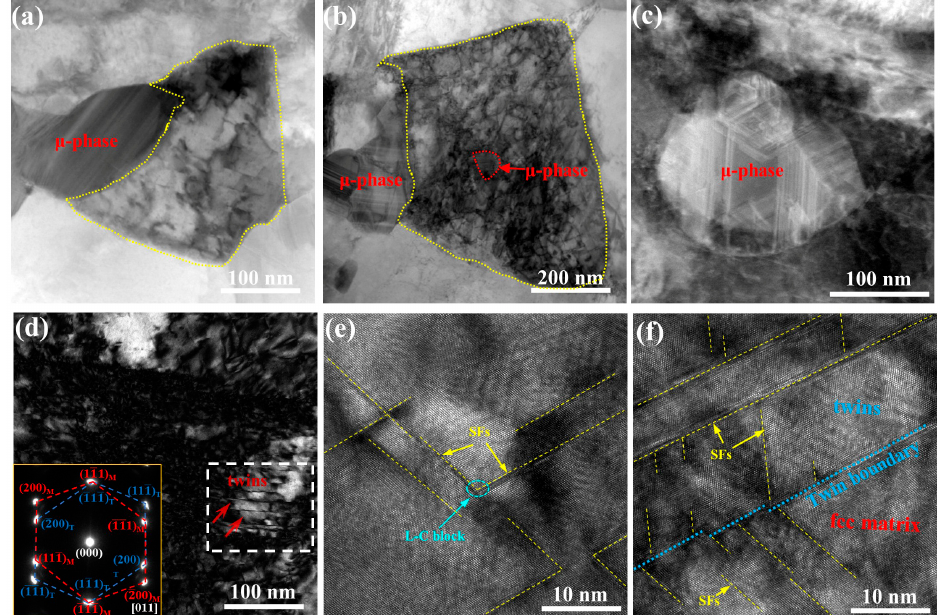
Figure 6. The room temperature deformation microstructure of the 1000 ◦ C − annealed sample: ( a , b ) sub-micron grains formed after the µ -phase pinning of grain boundaries, and a large number of dislocations have accumulated in the grains; ( c ) TEM dark-field pattern of deformable µ -phase; ( d ) deformation twins form within the grains, which can be confirmed by the selected electron dif-fraction pattern of the [011] zone axis; ( e , f ) high-resolution TEM patterns obtained from the fcc grains show the formation of SFs, L-C blocks, and